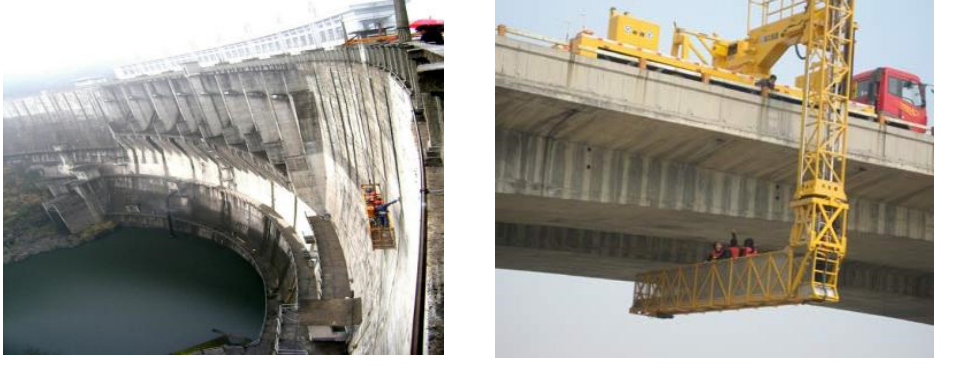
Figure 1. Conventional inspection method.